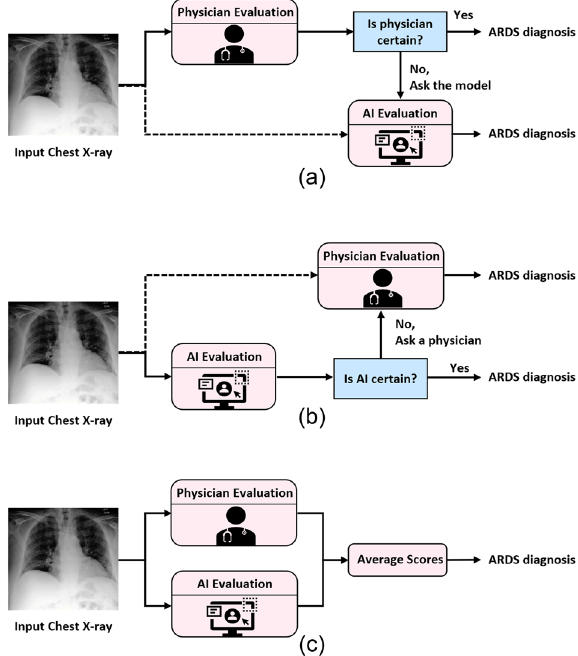
Fig. 2 Schematic diagram of the proposed strategies for physician-AI collaboration. a Shows the proposed AI-aided physician framework, b shows the physician-aided AI framework, and c shows the average scoring framework. It can be both basic and weighted average.